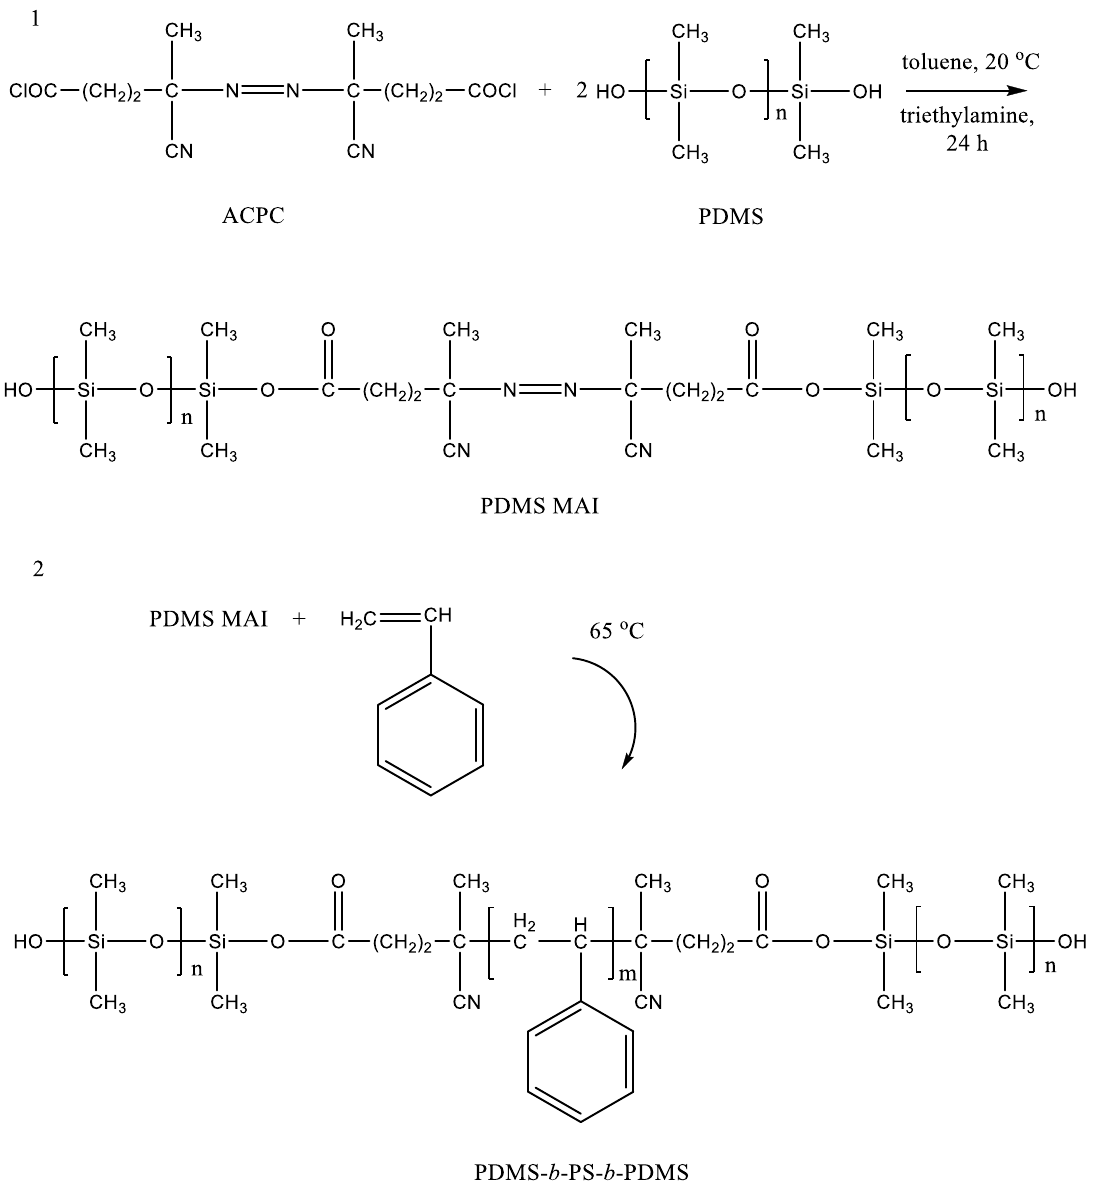
Figure 2. Stages of synthesis of the macroinitiator PDMS MAI (1) and triblock copolymer PDMS-b-PS-b-PDMS (2). Adopted from Ref. [23].